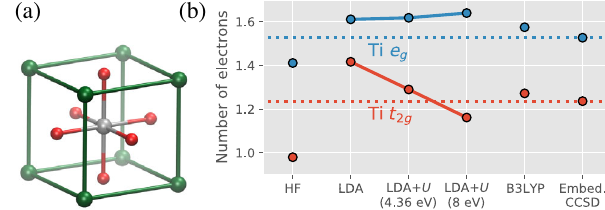
FIG. 6. (a) Unit cell of cubic SrTiO 3 with Sr in green, Ti in silver, and O in red. (b) Combined number of electrons in the e and t 2 orbitals of Ti based on a Löwdin population analysis. The g dotted lines mark the embedded CCSD results to allow for easier